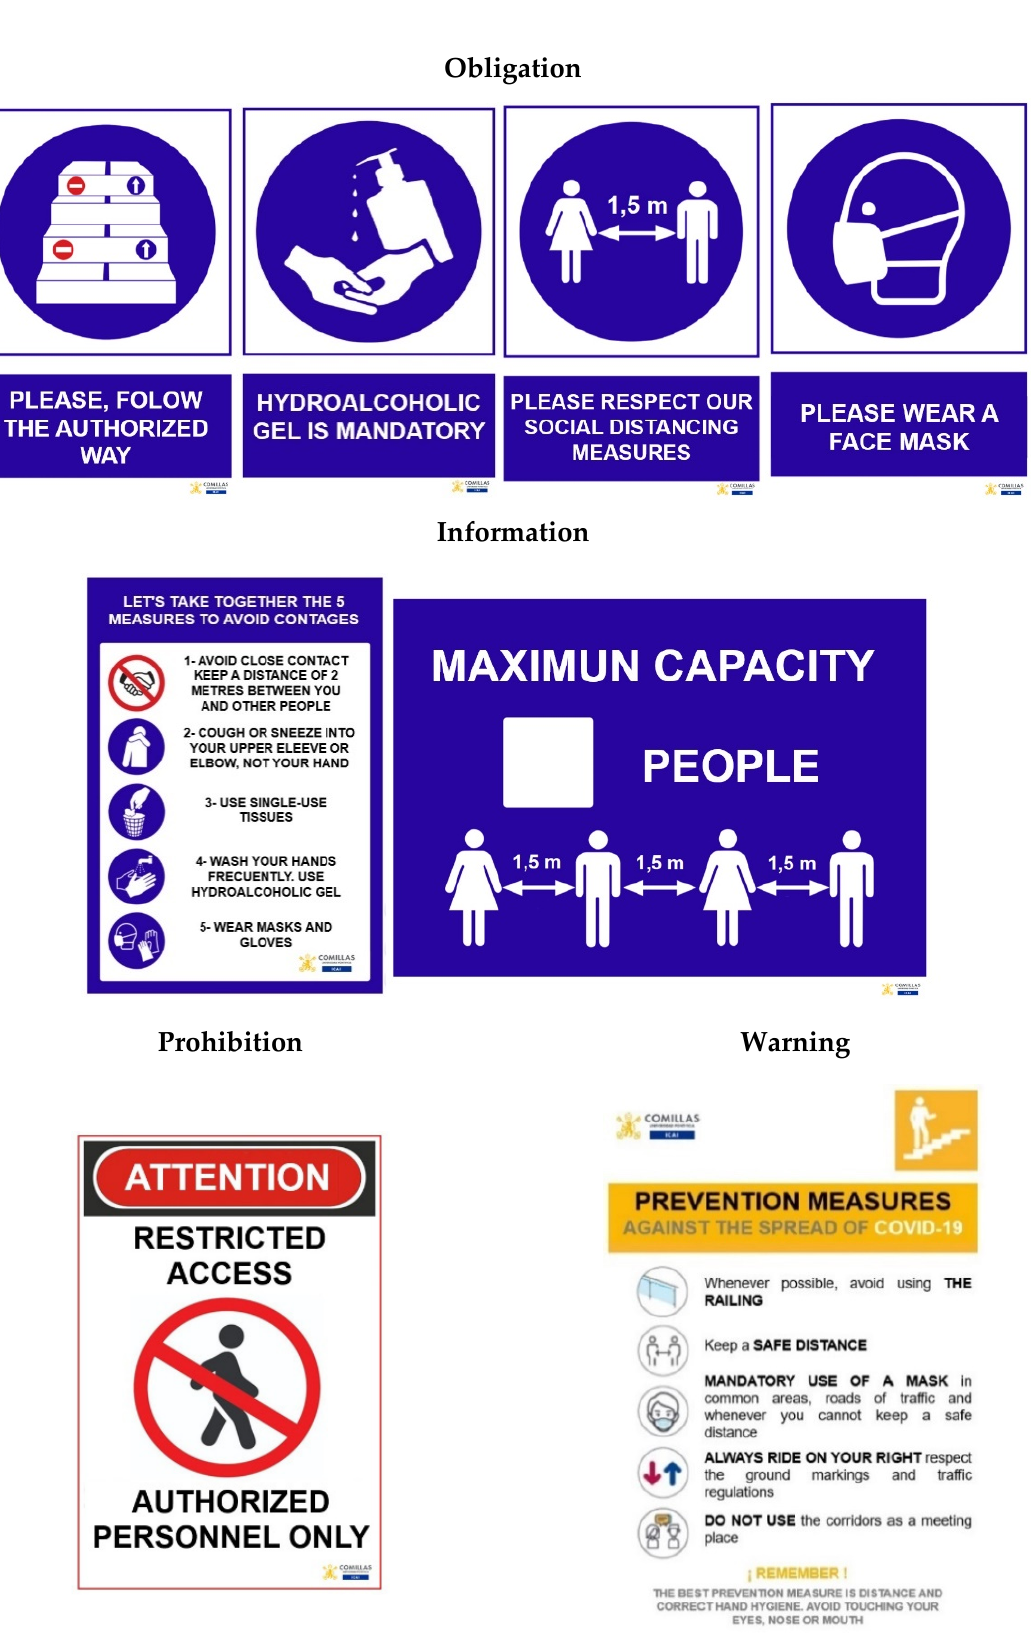
Figure 5. Informative markers.